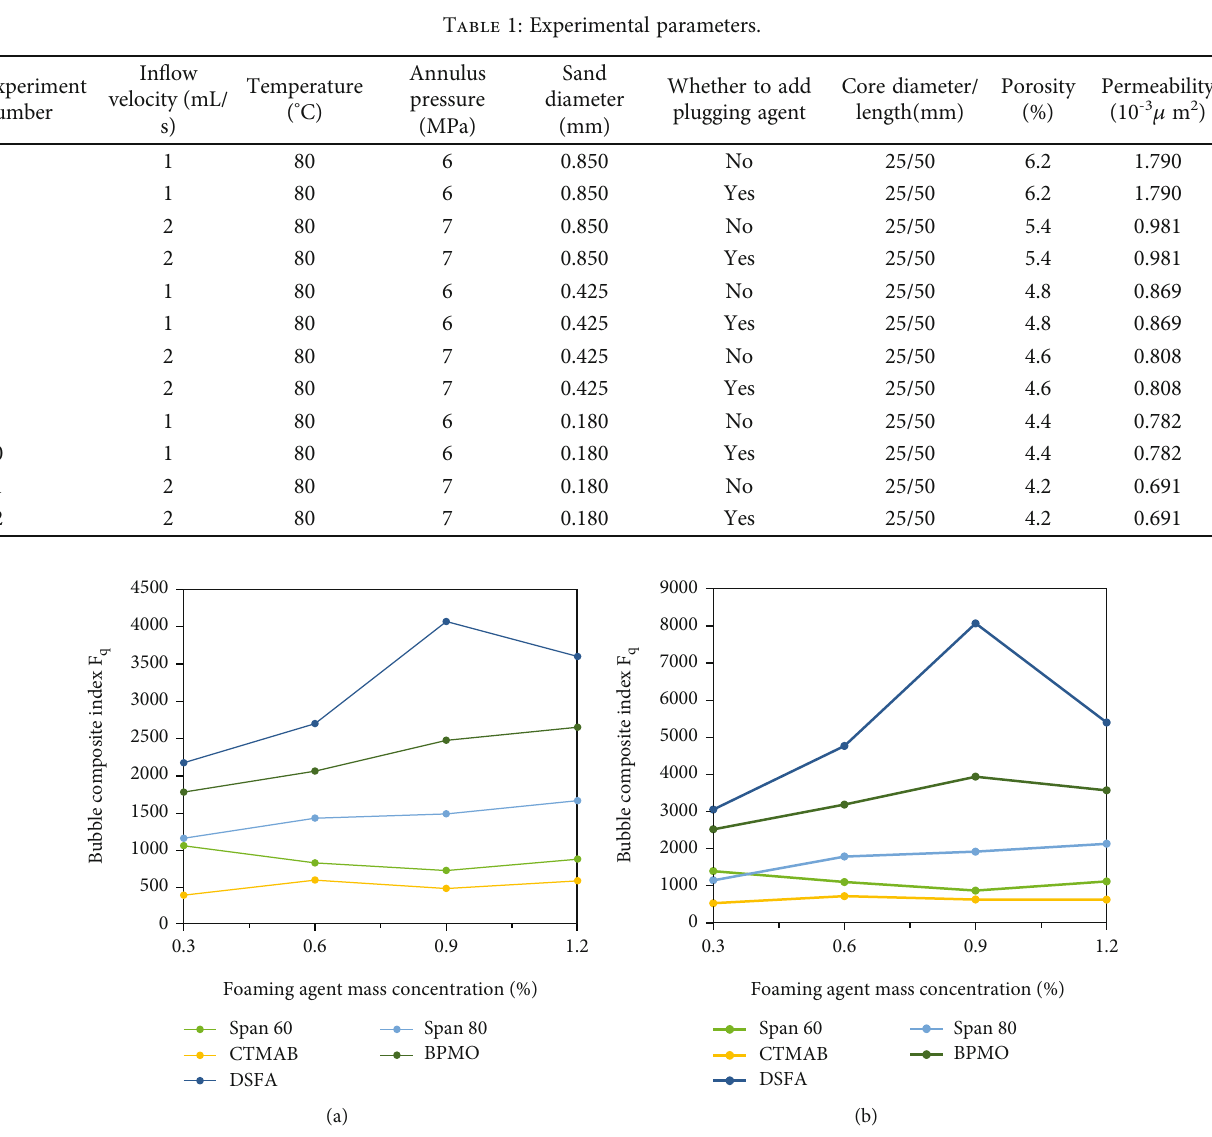
Figure 5: The foaming performance of di ff erent foaming agents in kerosene (a) and diesel Figure 3. The overall experimental process was to take white sand and place it in the middle of the core to simulate cracks and put the core into the core holder. The foam gel plugging agent was added on the left side of the core, the drilling fl uid was replaced with groundwater, and the plugging agent was driven into the core fractures. The fl ow rate of groundwater fl owing into the annulus of the core, annulus pressure, and core back pressure parameters were set. A graduated cylin- der was placed at the exit, and the amount of drilling fl uid lost during this time period was recorded. For comparison, we did not add a plugging agent in the comparison experi- ment to test the leakage of drilling fl uid through di ff erent degrees of fractures in a certain period of time. Sand particle